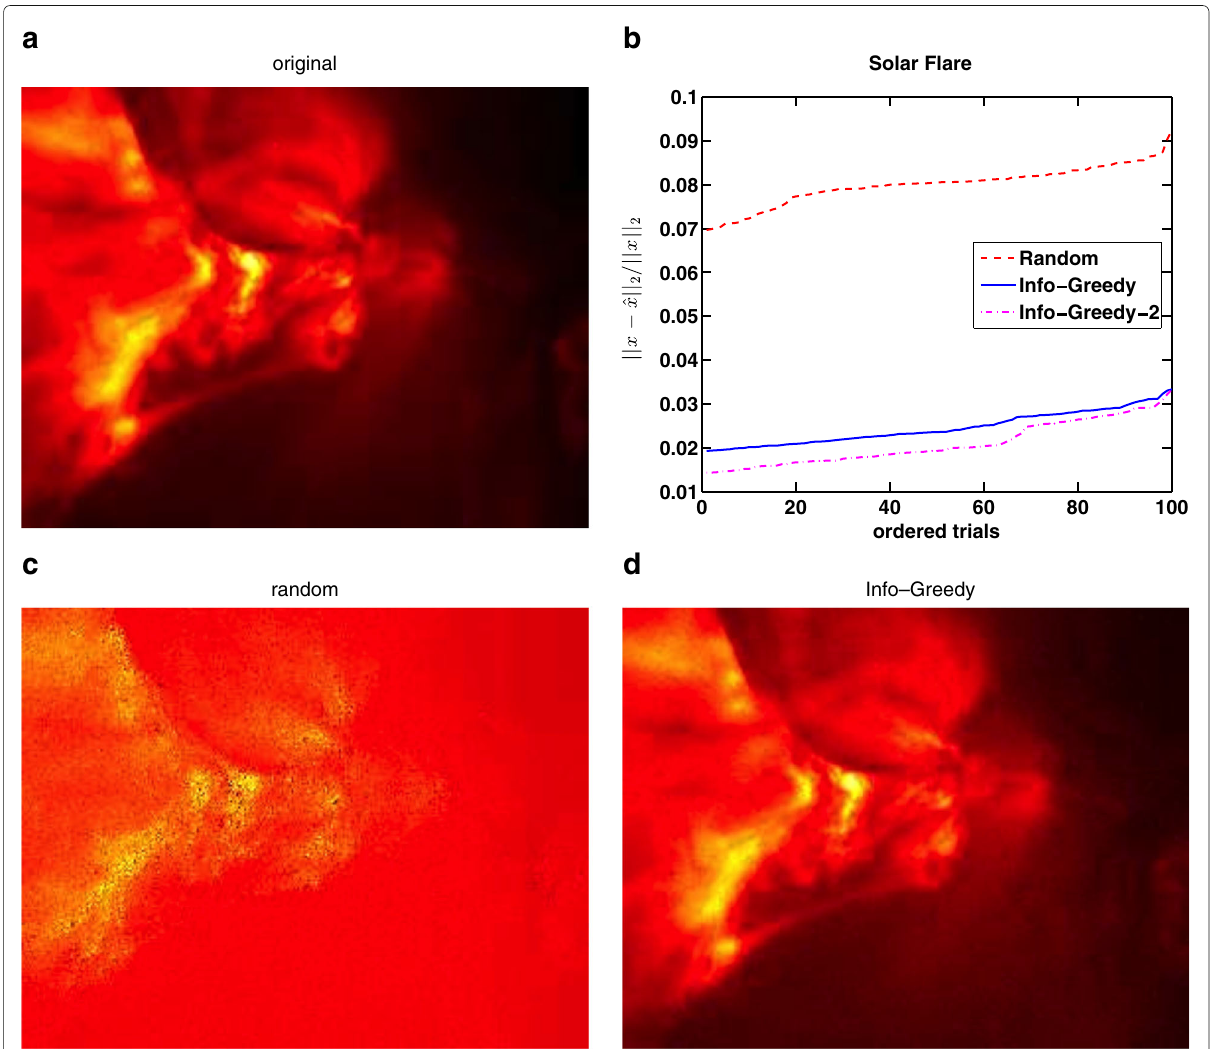
Fig. 6 Recovery of solar flare images of size 224 by 288 with K = 90 measurements and no sensing noise. We used the first 50 frames to estimate the mean and covariance matrix of a single Gaussian. a original image for 300th frame. b Ordered relative recovery error of the 200th to the 300th frames. c Recovered the 300th frame using random measurement. d Recovered the 300th frame using Info-Greedy